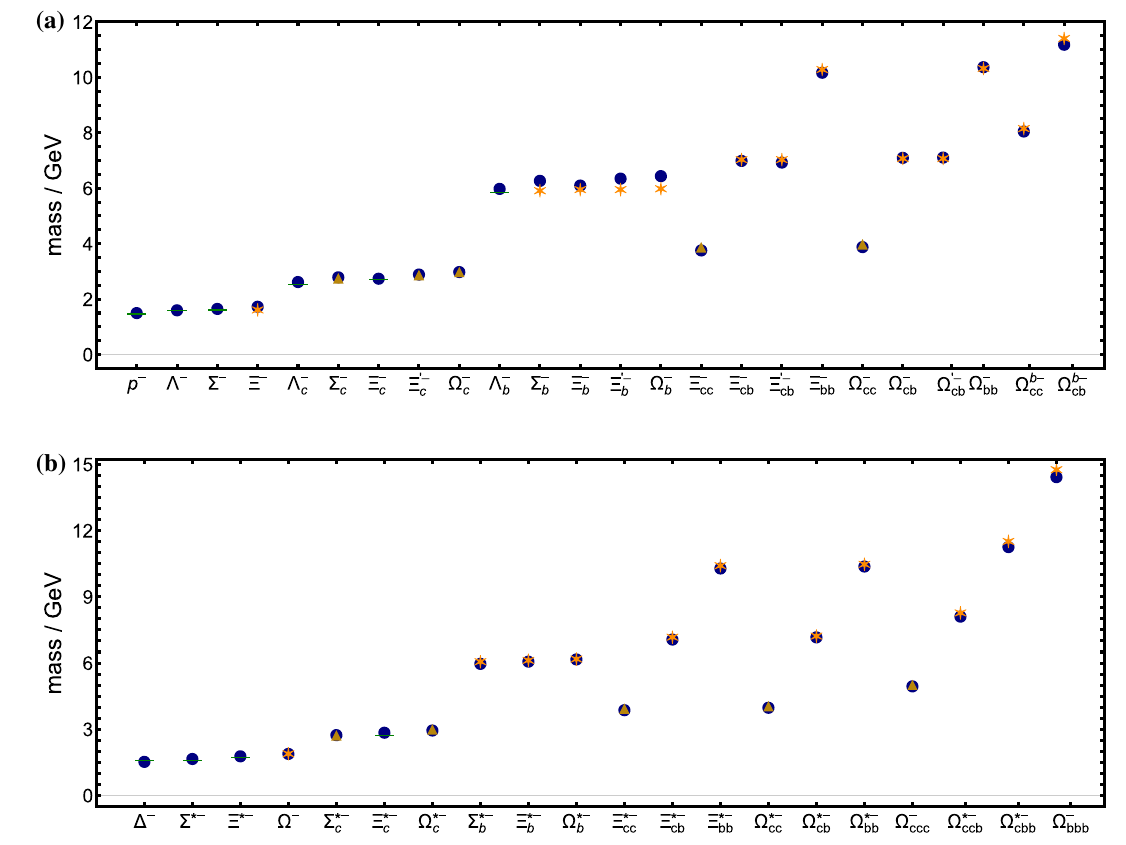
Fig. 5 Upper panel – a CI computed masses (in GeV) of ground-state flavour-SU ( 5 ) J P = 1 / 2 − baryons in Table 5 compared with experi- ment[1](greenbars),lQCD[22](goldtriangles),orthree-bodyFaddeev equation results [39] (orange asterisks). Lower panel – b Similar com-